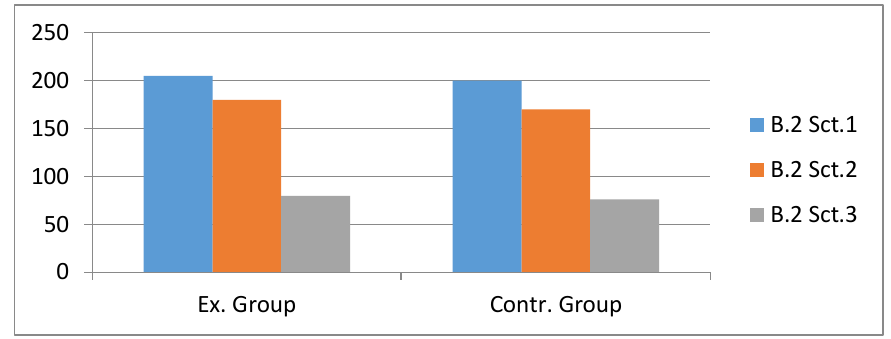
Figure 2. Test results for questions of block 2 at ascertaining stage of